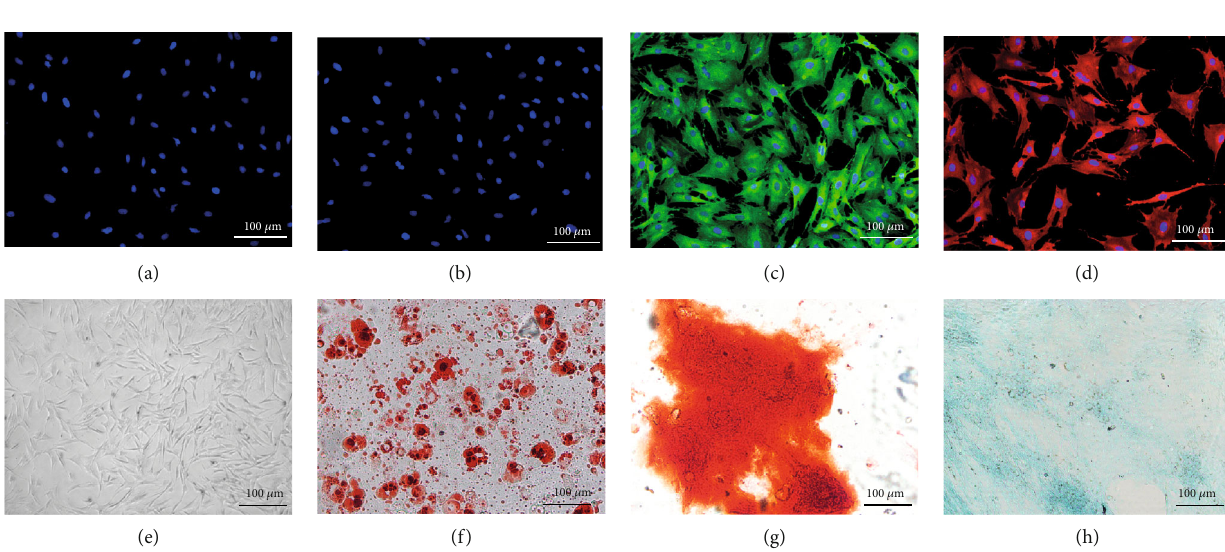
Figure 1: Isolation and identi fi cation of TSPCs: (a – d) immuno fl uorescence staining of CD3 (a), CD34 (b), CD44 (c), and CD90 (d); (e) cell morphology of TSPCs on the tissue culture plate under a light microscope; (f – h) Oil red O staining, Alizarin red staining, and Alcian blue staining of TSPCs after the induction of adipogenesis, osteogenesis, and